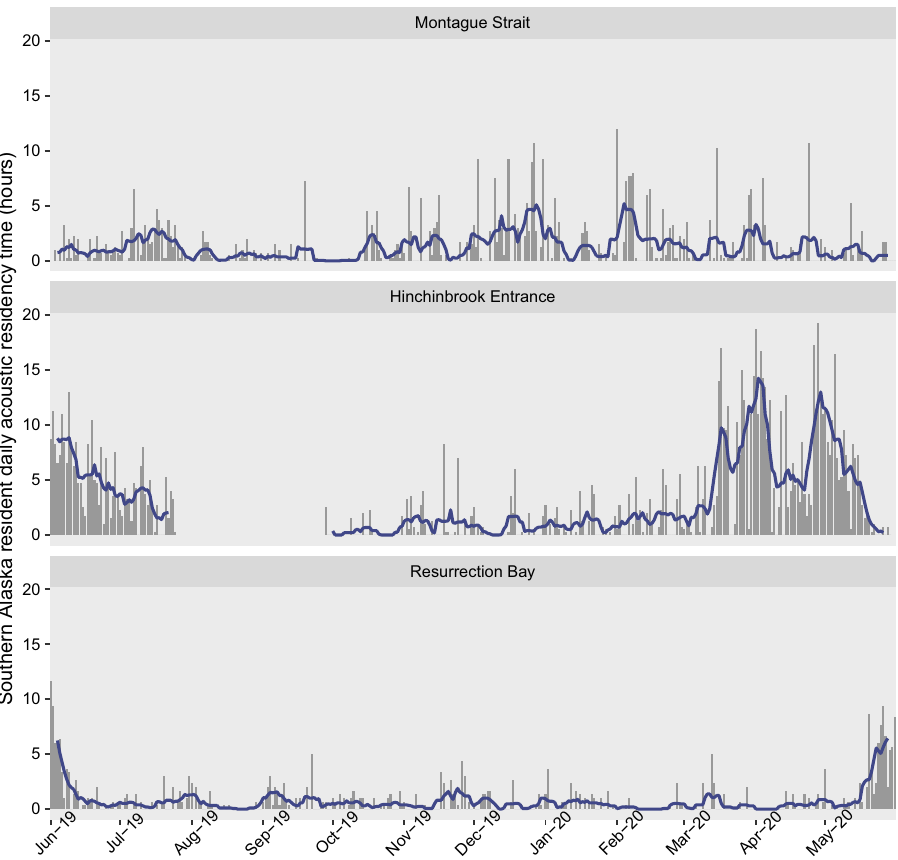
Figure 3. Hours per day that southern Alaska resident killer whales were detected in Montague Strait, Hinchinbrook Entrance, and Resurrection Bay, Gulf of Alaska, June 2019 to May 2020. Gray bars represent daily hours with detections, blue line is a weekly rolling average. No data were available at Hinchinbrook Entrance from July 26th–September 27th, 2019 and May 30th–31st, 2020 and at Montague Strait from September 25th–26th,